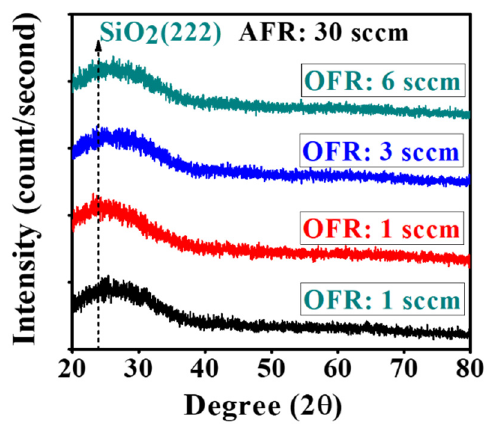
Figure 3. The amorphous phase of the as-deposited IGZO films at different O 2 flow rates was confirmed by XRD analysis.